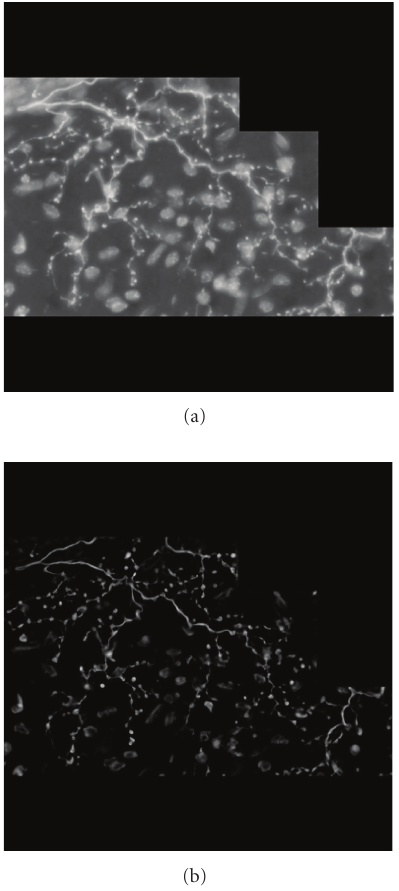
Figure 12: Maximum Intensity Projection (MIP) of micro-CT image of rat heart coronary arteries. (a) Input image; (b) Processed image.